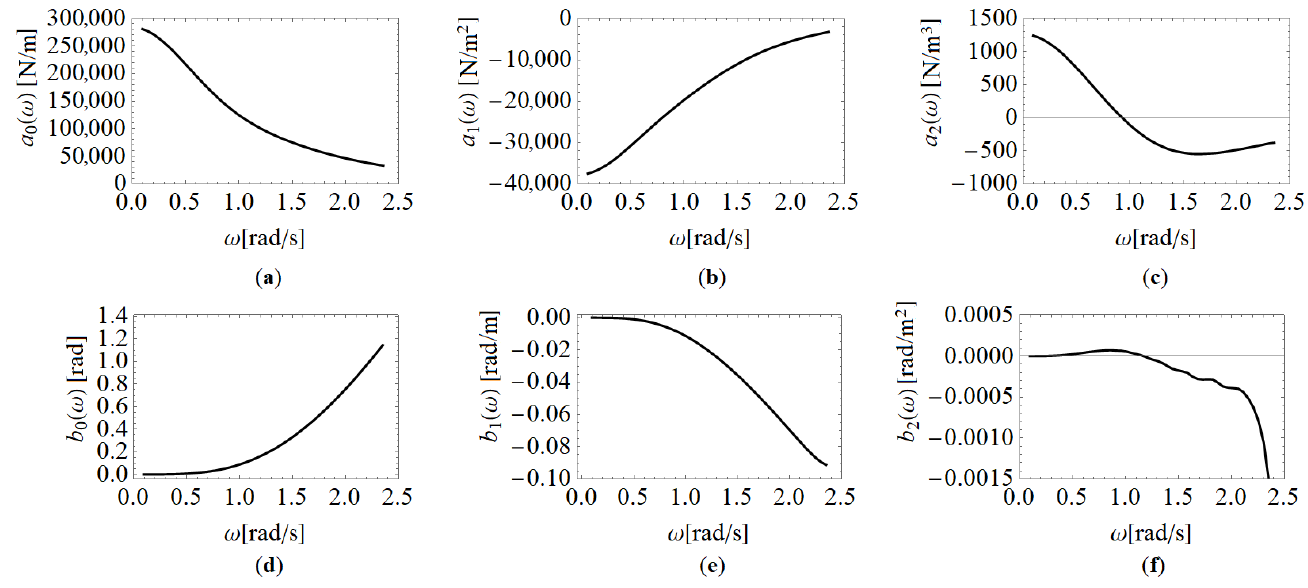
Figure 7. The excitation force polynomial coefficients for the amplitude, ( a ) a 0 ( ω ) , ( b ) a 1 ( ω ) , ( c ) a 2 ( ω ) , and phase ( d ) b 0 ( ω ) , ( e ) b 1 ( ω ) , ( f ) b 2 ( ω ) , as function of the wave frequency. The accuracy of the fitted wave excitation amplitude f e ( z , ω ) and phase θ e ( z , ω ) are illustrated in Figure 8, where the continuous line denotes the fitted curve, while the dots are the data calculated by NEMOH.